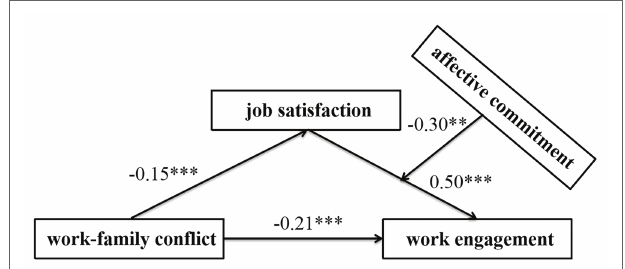
FIGURE 2 | Path coefficients of the moderated mediation model. JS, job satisfaction; AC, affective commitment. ** p < 0.01, *** p < 0.001.